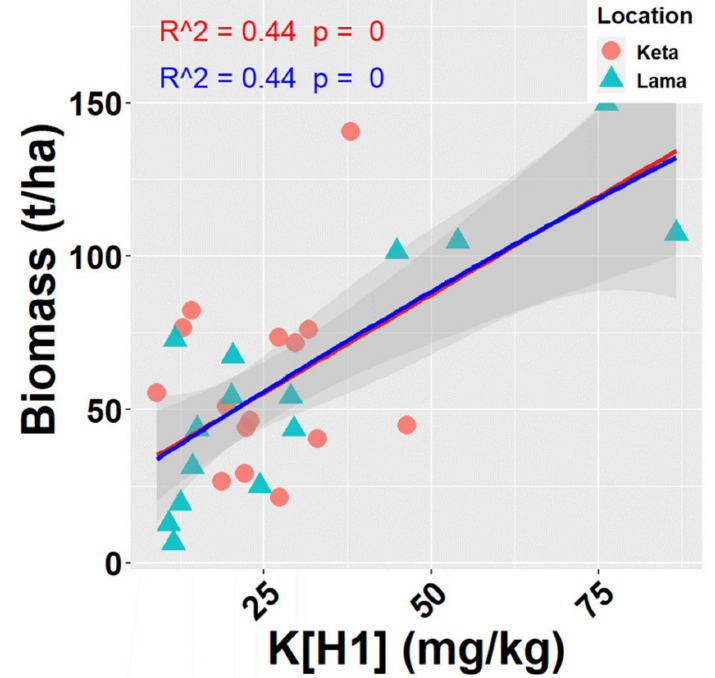
Figure 6. Relationships of K content in soil in depth 0–10 cm (K[H1] (mg/kg)) to total biomass of tree species (aboveground living + deadwood). Points represen t values at individual sample plots. Lines represent fitted models (red—linear, blue—quadratic), and grey areas show 95% confidence intervals around the fitted